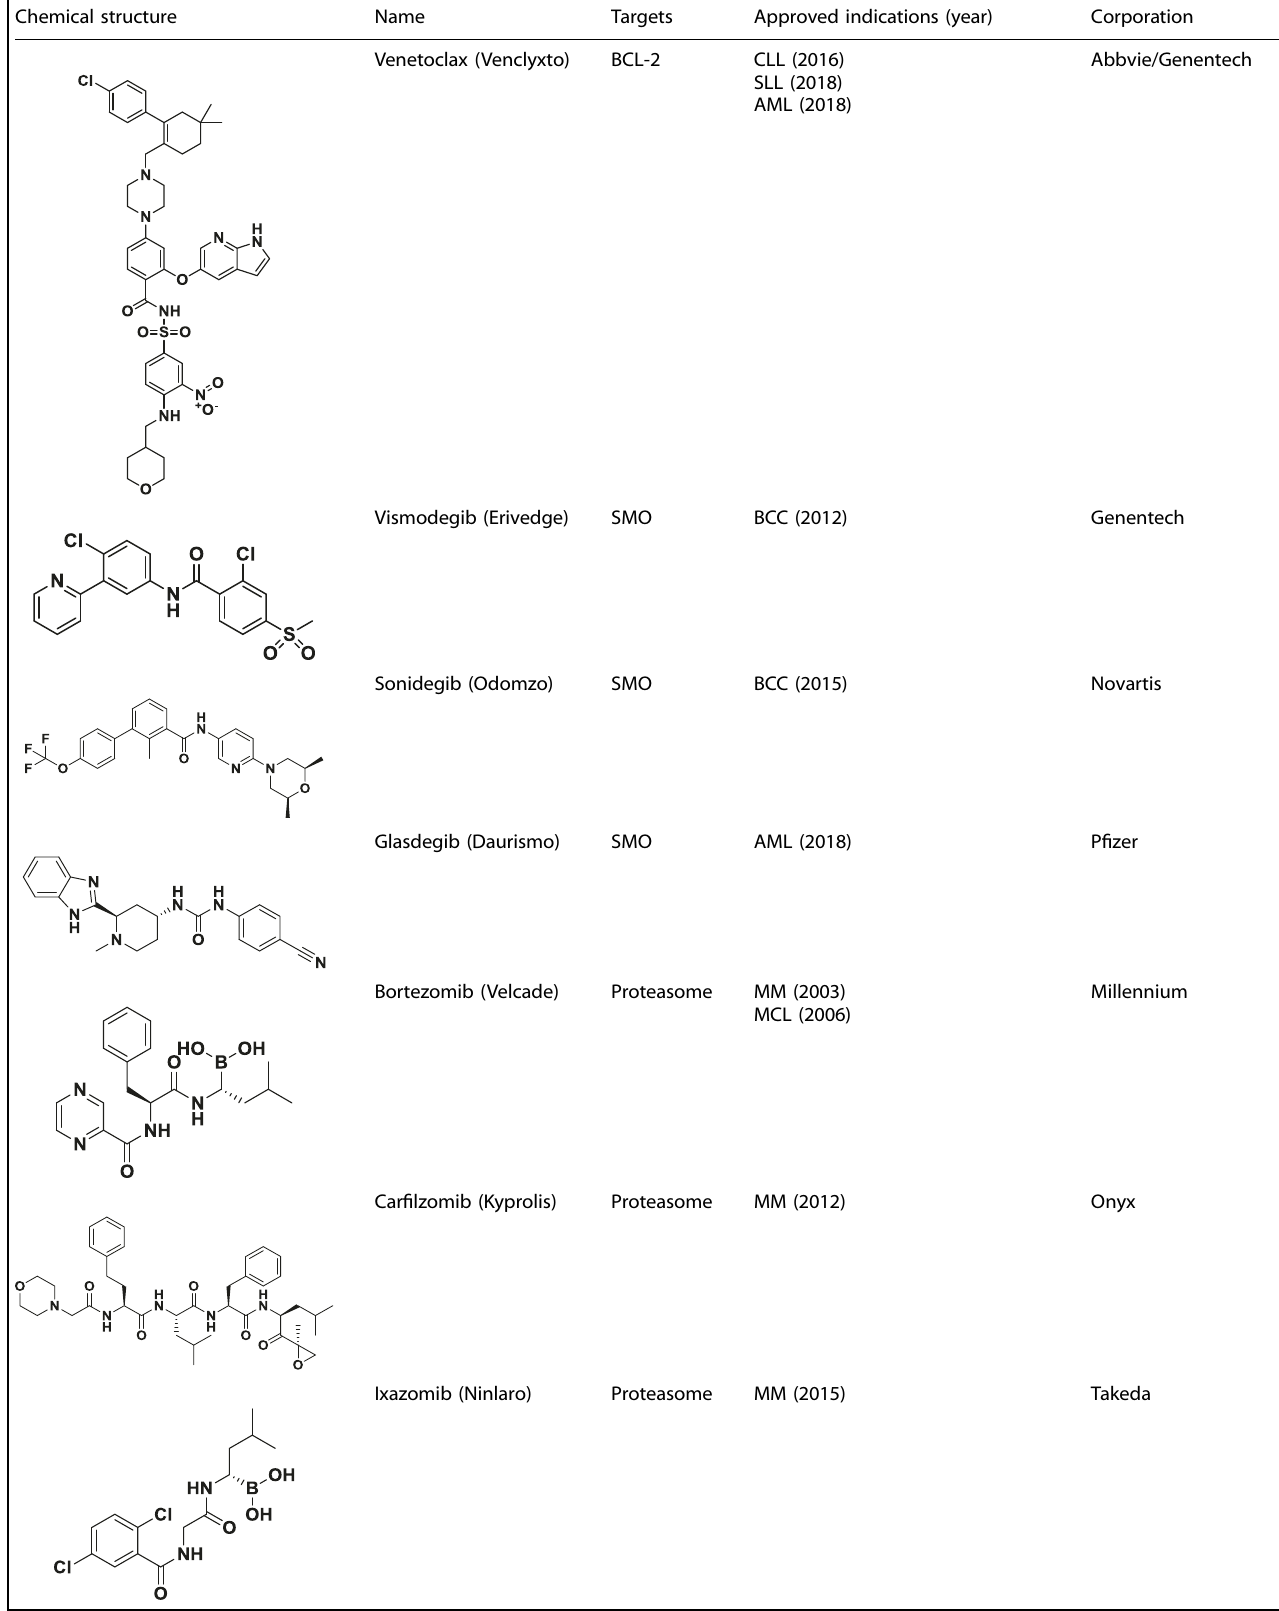
Table 5. Properties of approved small-molecule inhibitors of BCL-2, hedgehog pathway, proteasome, and